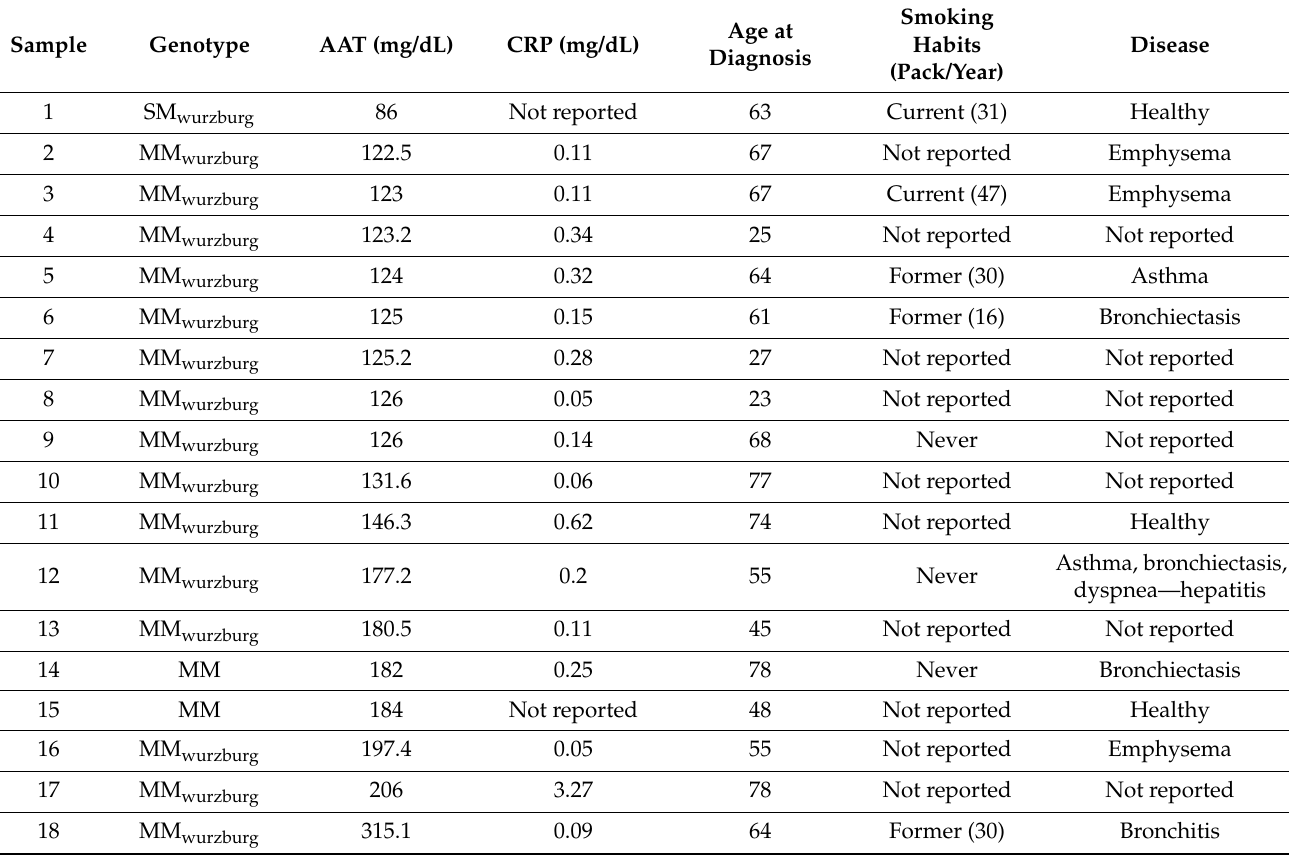
Table 1. Clinical data of selected and re-examined patients with the M wurzburg IEF